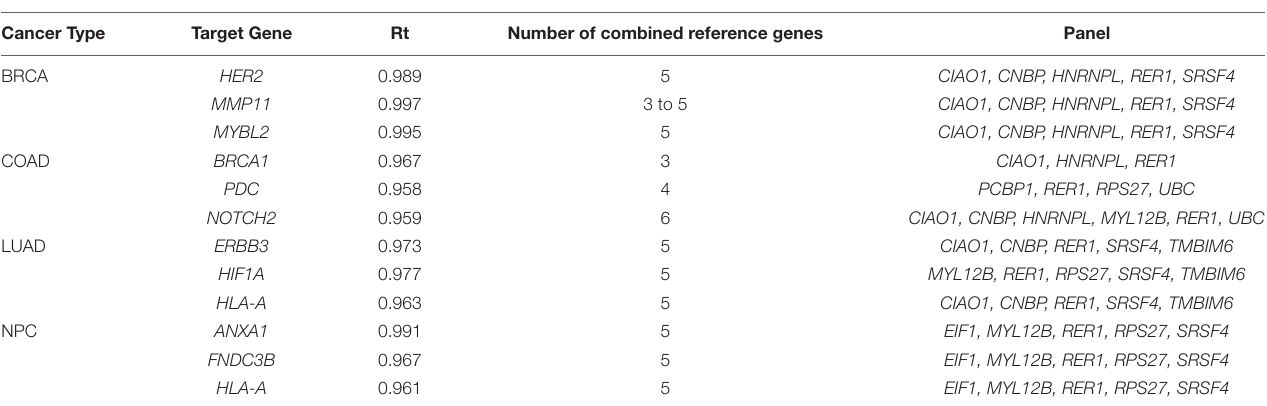
FIGURE 4 | The best correlation coefficient (Rt) for each number of combined reference genes. The target gene was normalized to the corresponding number of combined reference genes, and the best Rt was identified from the various combinations and plotted. TABLE 3 | Rt of the best combined reference genes for each target gene in each cancer